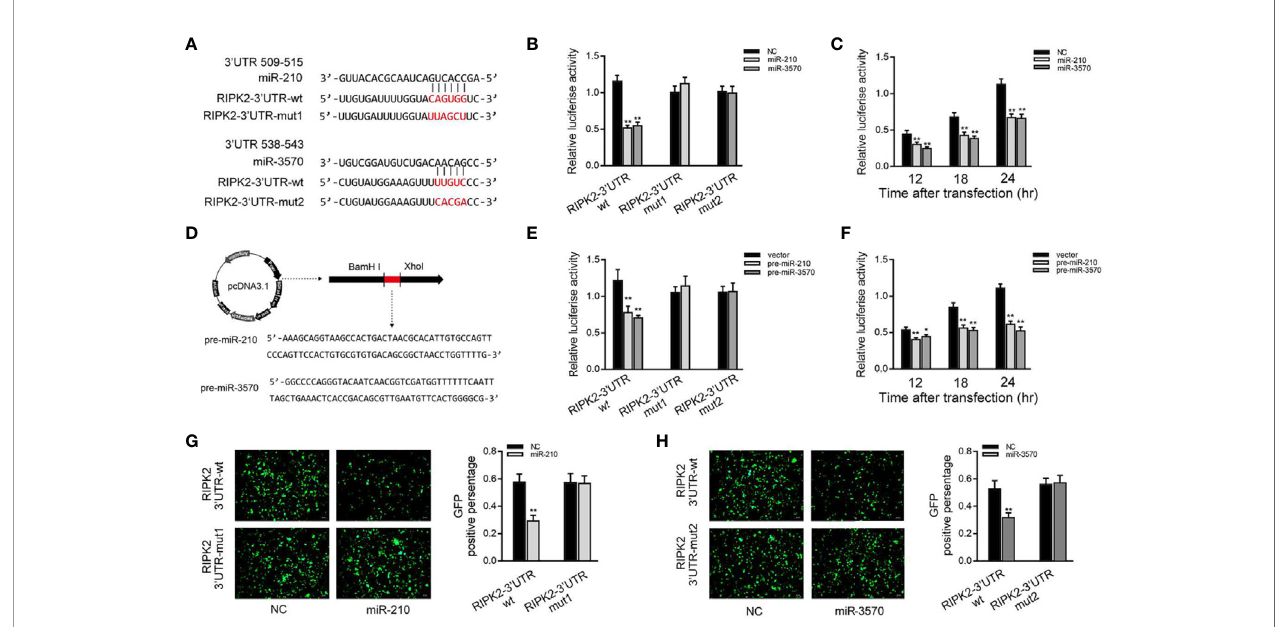
FIGURE 3 | miR-210 and miR-3570 target the miiuy croaker RIPK2 gene. (A) Schematic diagram of miR-210 and miR-3570 and their predicted binding sites in RIPK2 3 ′ UTR. (B) The dual luciferase reporter assay was applied to detect the regulation effect of miR-210 and miR-3570 mimics on wild-type RIPK2 3 ′ UTR (RIPK2 3 ′ UTR wt) or mutant-type of RIPK2 3 ′ UTR (RIPK2-3 ′ UTR mut1/mut2). EPC cells were transfected with RIPK2-3 ′ UTR wt (100 ng) or RIPK2-3 ′ UTR mut1/mut2 (100 ng), together with miR-210 (100 nM), miR-3570 (100 nM), or NC (100 nM) for 24 h, and then the luciferase activity was determined. (C) In EPC cells, the effect of miR-210 and miR-3570 on the luciferase activity of RIPK2 3 ′ UTR was detected at different time points as indicated. (D) The pre-miR-210 and pre-miR-3570 sequences and schematic diagram for their plasmid. (E) EPC cells were contransfected RIPK2-3 ′ UTR wt (100 ng) or RIPK2-3 ′ UTR mut1/mut2 (100 ng), together with the pre-miR-210 plasmid (200 ng), pre-miR-3570 plasmid (200 ng) or pcDNA3.1 vector (200 ng). (F) The effect of pre-miR-210 plasmid, pre-miR-3570 plasmid on the luciferase activity of RIPK2-3 ′ UTR was detected at different time points. Among them, pre-miR-210 and pre-miR-3570 plasmids were co-transfected into EPC cells with pcDNA3.1 vector. The luciferase activity value was achieved against the renilla luciferase activity. (G, H) EPC cells were co-transfected with the wild-type mVenus-RIPK2-3 ′ UTR or mutant mVenus-RIPK2-3 ′ UTR (100 ng), together with NC (100 nM), miR-210 (100 nM) (G) , and miR-3570 (100 nM) (H) . At 48 h posttransfection, the fl uorescence intensity was evaluated by enzyme-labeled instrument (Thermo Scienti fi c Varioskan LUX). the fl uorescence intensity was observed by Leica DMiL8 fl uorescence microscope. Scale bar, 20 m m; original magni fi cation ×10. All luciferase activity was normalized to renilla luciferase activity. All data are presented as the means ± SE from three independent triplicate experiments. **p < 0.01; *p < 0.05 versus the